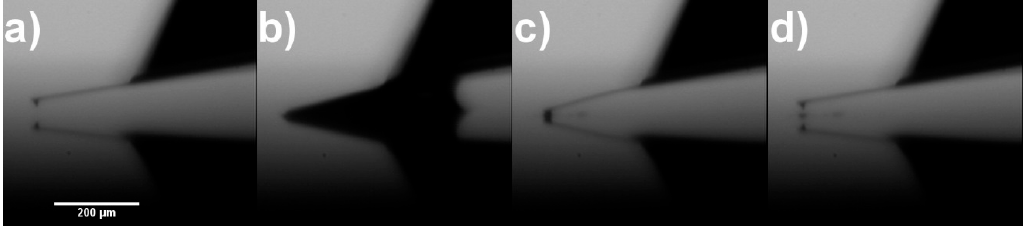
Figure 5. Optical images showing alignment of an atomic force microscope (AFM) tip with a silicon